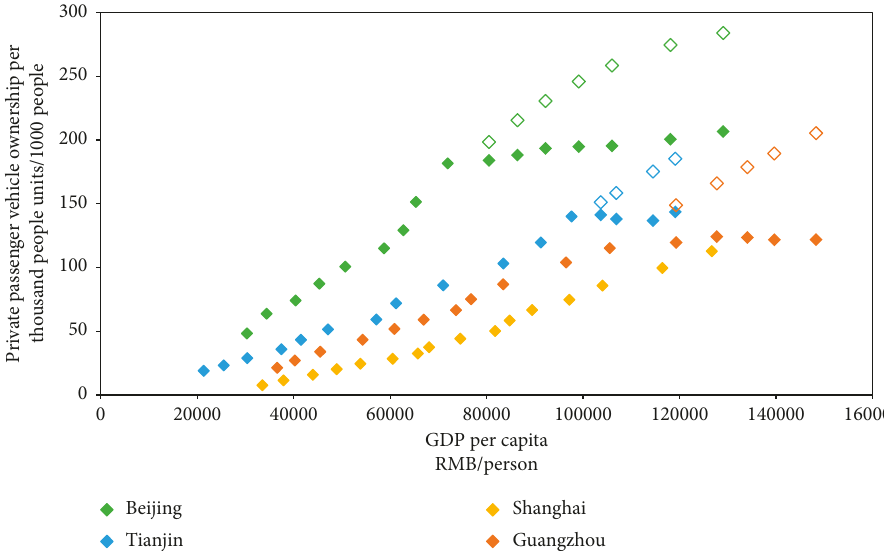
Figure 11: Actual and fitted private passenger vehicle ownership per thousand people (unfilled diamonds represent the fitted results with no vehicle purchase restriction policies and filled ones represent the actual